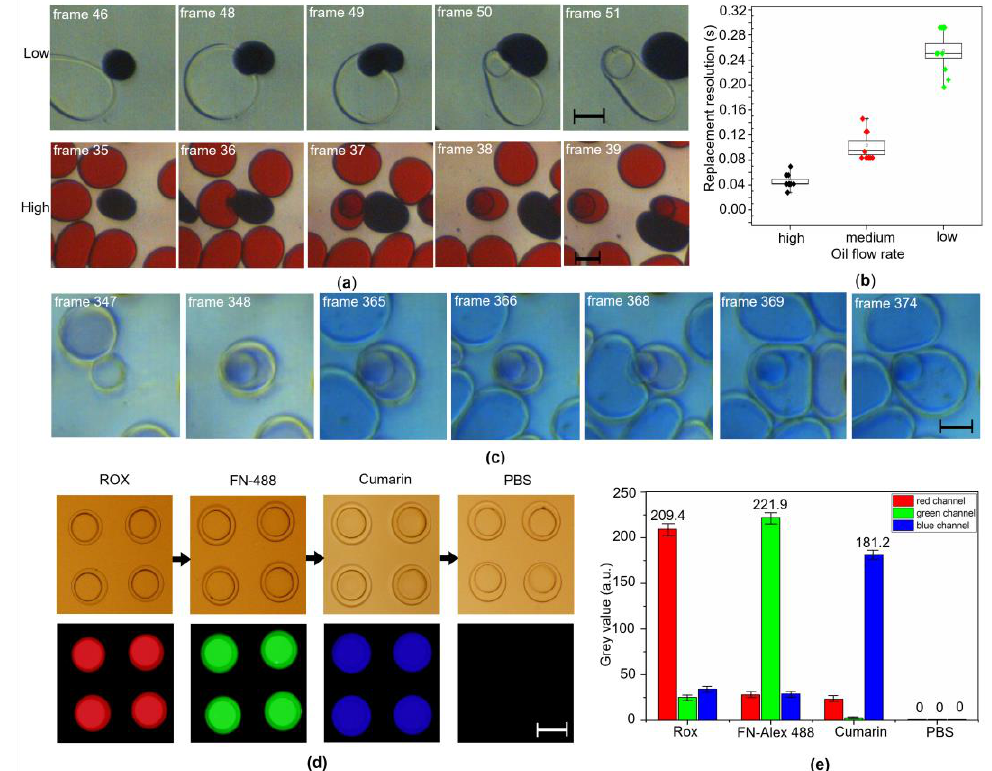
Figure 3. ( a ) Time lapse images of one SEW during the replacement of two aqueous droplets, black to colorless, under a lower oil flow rate (top), and black to red under a higher flow rate (bottom). ( b ) Column scatter plot of the replacement times at 10 positions under varying oil flow rates. ( c ) Time lapse images of droplet replacement (dark blue by light blue) for a single SEW structure. ( d ) Sequential replacement of differently colored droplets under an SEWs array (2 × 2). The top and bottom rows are the bright-field and corresponding fluorescence images, respectively. At the appropriate oil flow rate, ROX droplets are initially trapped under the SEWs, followed by successive replacement with FN-488, 7-Hydroxycoumarin and finally PBS droplets. ( e ) Statistical distribution of the mean gray values of the fluorescence images for three channels, split up and determined using ImageJ software. Scale bars: 100 µm .